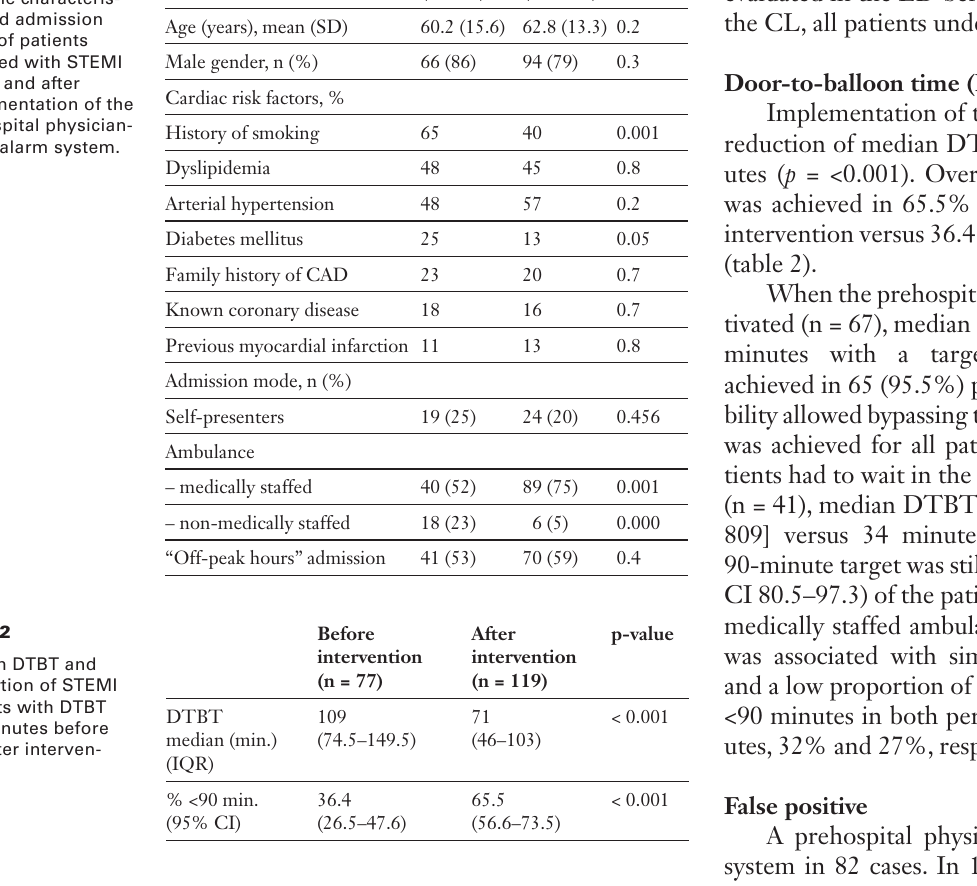
Baseline characteris- tics and admission mode of patients admitted with STEMI before and after implementation of the prehospital physician- based alarm system.